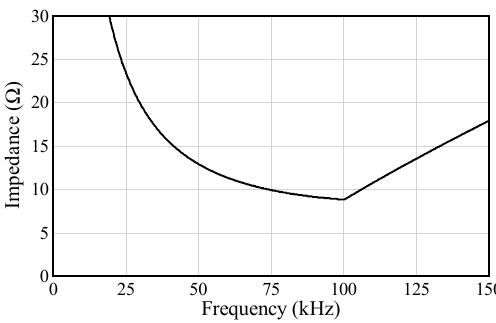
Figure 6. Z out 2 –f characteristics of V out 2 -side circuit.